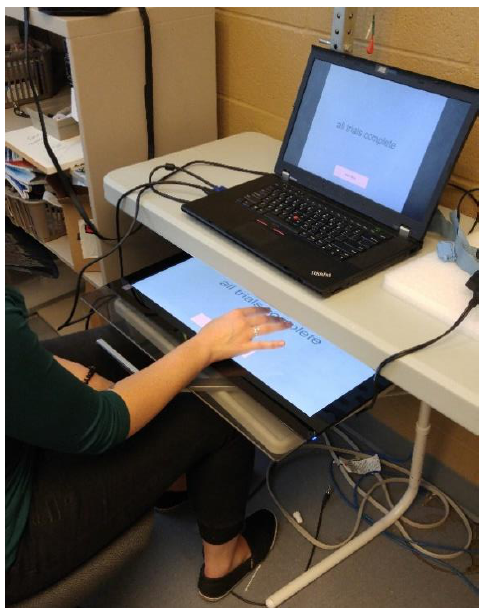
Figure 2. Motor skill acquisition tracing task setup. A laptop is placed on the table, displaying the motor training task. A large touchscreen is placed on a desk directly below the table, ensuring that the table blocks the participants’ view of their own arm. To control the sweep of each sinusoidal wave, participants were required to adjust to the velocity and amplitude of the traces by performing internal and external rotation of the right shoulder joint.